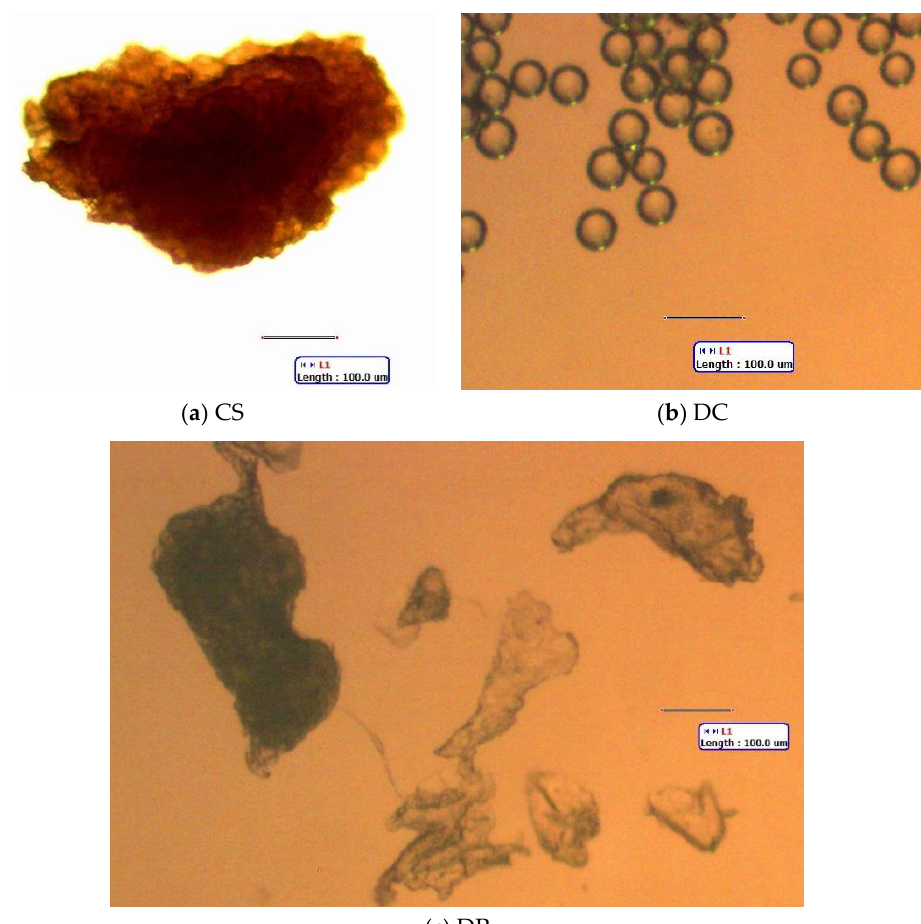
Figure 2. Representative microparticles added to lake phytoplankton. ( a ) CS (apricot kernel powder from a “coconut scrub” body wash). ( b ) DC (Dri-Cal polystyrene (PS) beads, 50 µm). ( c ) DP (polylactic acid fragments from a body wash). All scale bars: 100 µm. Standard light microscopy.